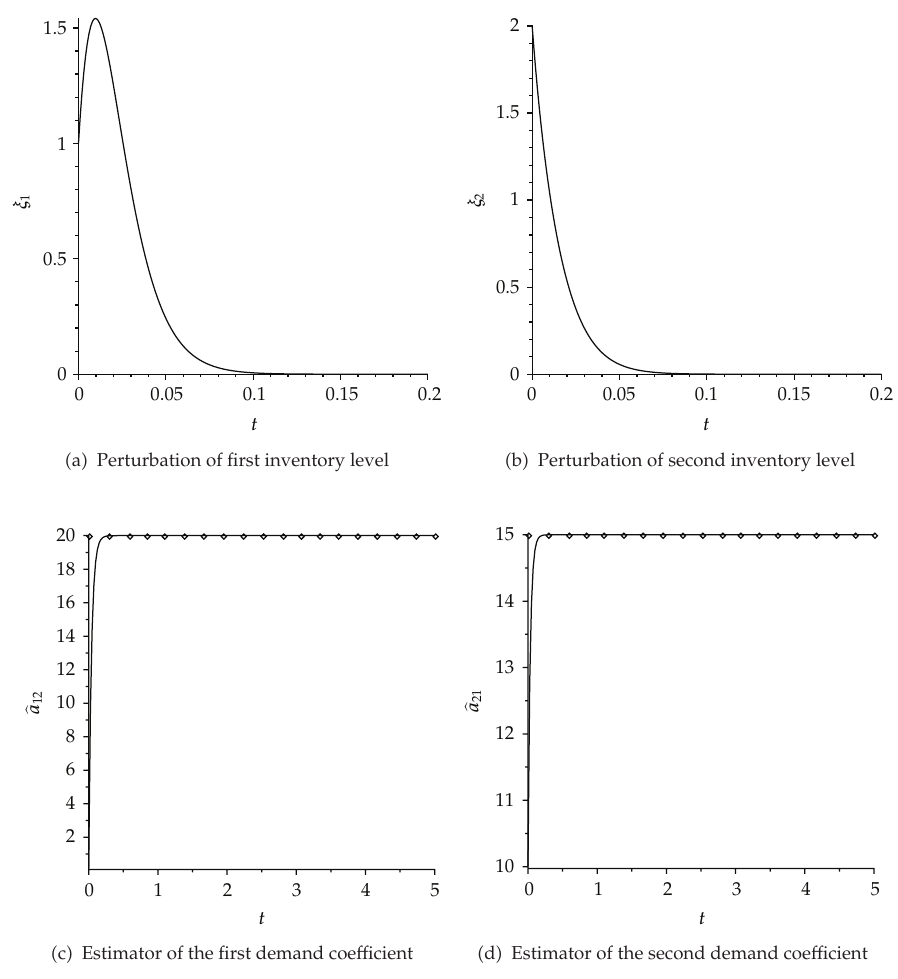
Figure 6: (cid:6) a (cid:7) and (cid:6) b (cid:7) are the perturbation of the first and second inventory levels about their inventory goal levels as the demand rate is an exponential function of the time. (cid:6) c (cid:7) and (cid:6) d (cid:7) are the di ff erence between dynamic estimators of the first and second demand rates and their real